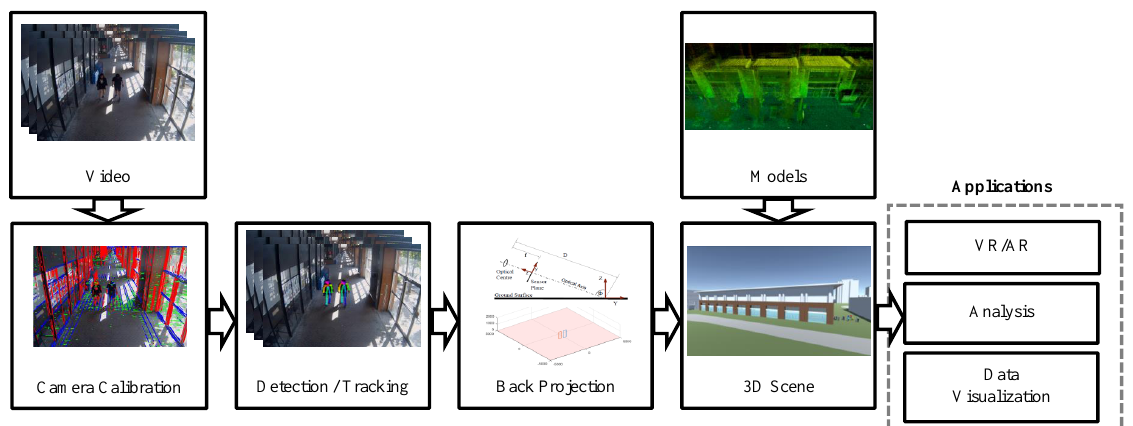
Figure 1. An urban modeling and analytics platform